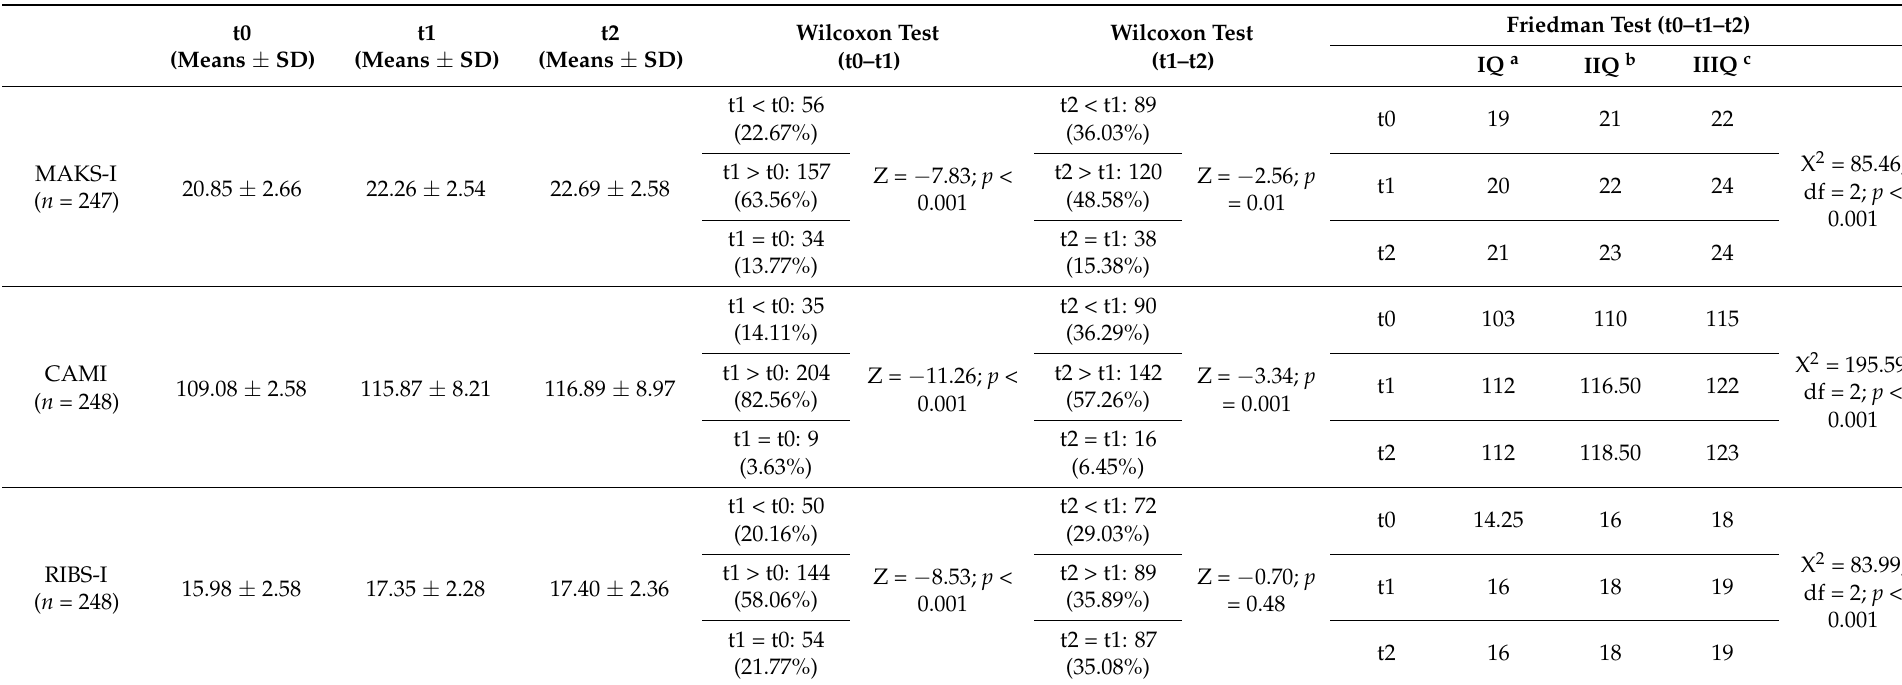
Table 2. Trend over time of the scores obtained in the knowledge of mental disorders (MAKS-I), the attitudes towards people who are mentally ill (CAMI), and the intended behaviour towards people with mental illness